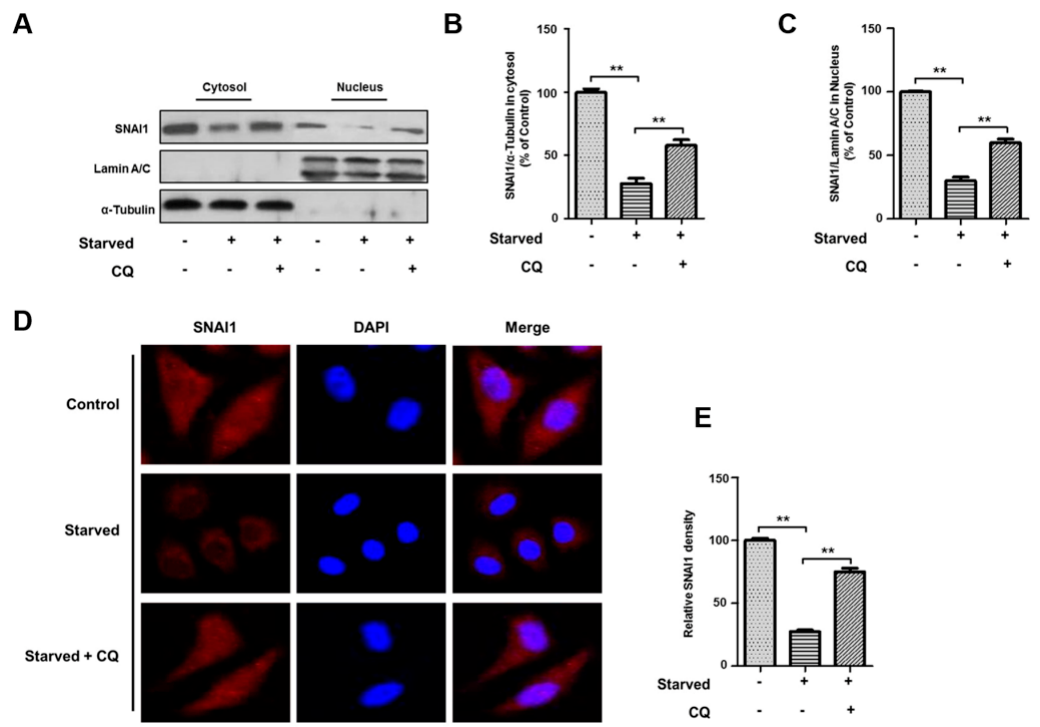
Figure 5. Autophagy-dependent degradation of SNAI1 in the cytosol inhibits SNAI1 translocation into the nucleus. ( A ) HeLa cells were starved in HBSS for 4 h with or without 20 µM chloroquine (CQ). Whole cell extracts were fractionated into cytosolic and nuclear extracts as described in the methods. Each fraction was analyzed by western blotting analysis. Both α -tubulin and lamin A/C were used as loading controls for the cytosolic and nuclear fractions, respectively. ( B and C ) Quantification of SNAI1. The levels of SNAI1 in the cytosol ( B ) and nucleus ( C ) were quantified using NIH ImageJ software. Data represent the mean (± S.D.) of three independent experiments (** p < 0.01). ( D and E ) Localization of SNAI1 in the cytosol and nucleus. HeLa cells were starved in HBSS in the presence or absence of 20 µM CQ. SNAI1 staining ( C ) in the cytosol or nucleus was determined by immunohistochemistry. Images were captured from at least 20 different areas by confocal microscopy (Olympus FV-1000), and the immunofluorescence of nuclear SNAI1 was quantified using NIH ImageJ software ( D ). Data represent the mean (± S.D.) of three independent experiments (** p < 0.01).